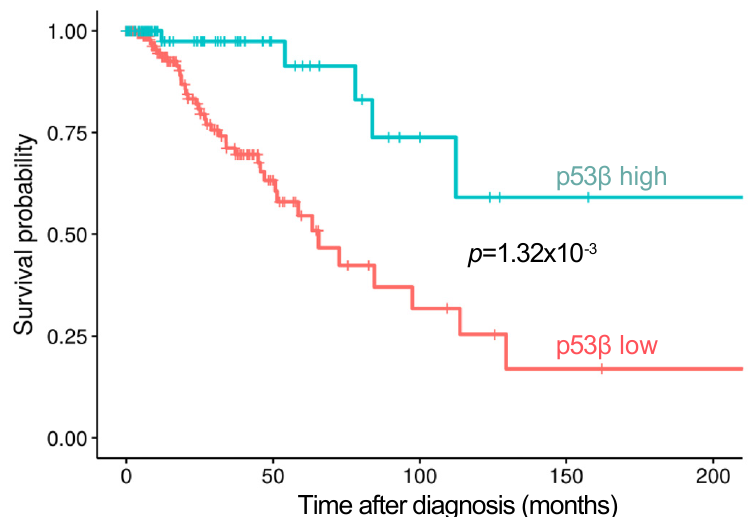
Figure 3. High levels of p53 β are associated with prolonged overall survival in patients with advanced stage (III/IV) breast cancer (TCGA breast cancer (BRCA) data [24,25]). N = 277; unadjusted p -value = 0.00132. The “expression low” cohort represents the following combination of samples: HER2 negative (39.6%, N = 80), HER2 positive (17.3%, N = 35), NA (36.6%; N = 74; including HER2 equivocal), and triple-negative breast cancer (6.4%, N = 13). The “expression high” cohort represents the following combination of samples: HER2 negative (41.3%, N = 31), HER2 positive (16.0%, N = 12), NA (32.0%; N = 24; including HER2 unequivocal), and triple-negative breast cancer (10.7%, N = 8). The cohort was 32.5% ( N = 90) TP53 mutant and 67.5% ( N = 187) TP53 wild type (WT). HER2-negative status was determined as; (1) ER − , PR+; (2) ER+, PR − ; (3) ER+, PR+; or (4) ER+, PR indeterminate. Methods for data analysis can be found in supplementary material.